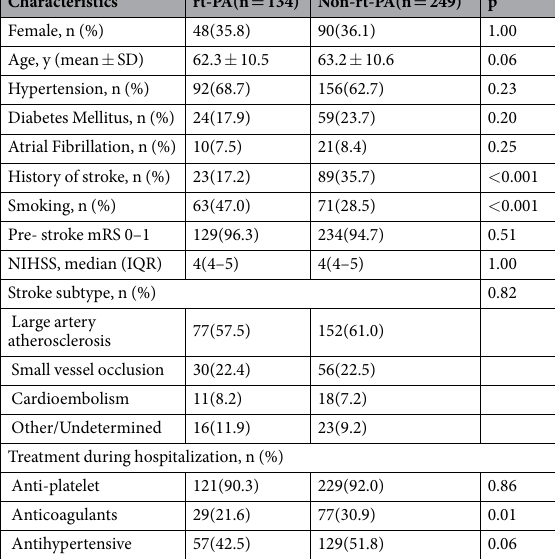
Table 1. Baseline Characteristics of Matched Patients with Mild Stroke. IQR: interquartile range; mRS: modified Rankin Scale; NIHSS: National Institutes of Health Stroke Scale; rt-PA: recombinant tissue plasminogen activator; SD: Standard Deviation.